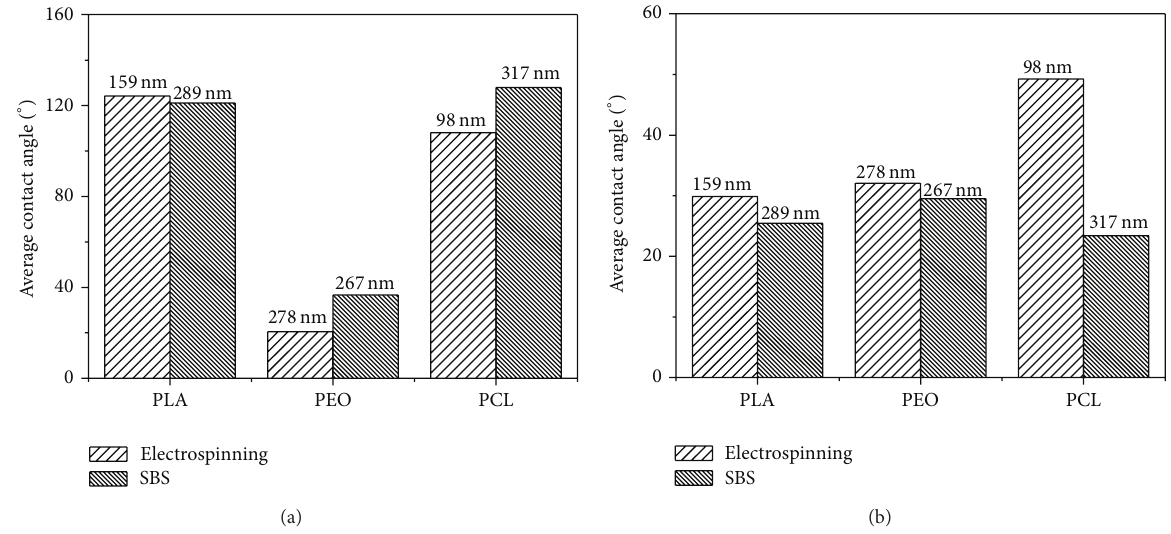
Figure 8: Effect of the fiber average diameters on contact angle (a) water and (b) ethylene glycol as a function of the spinning technique.